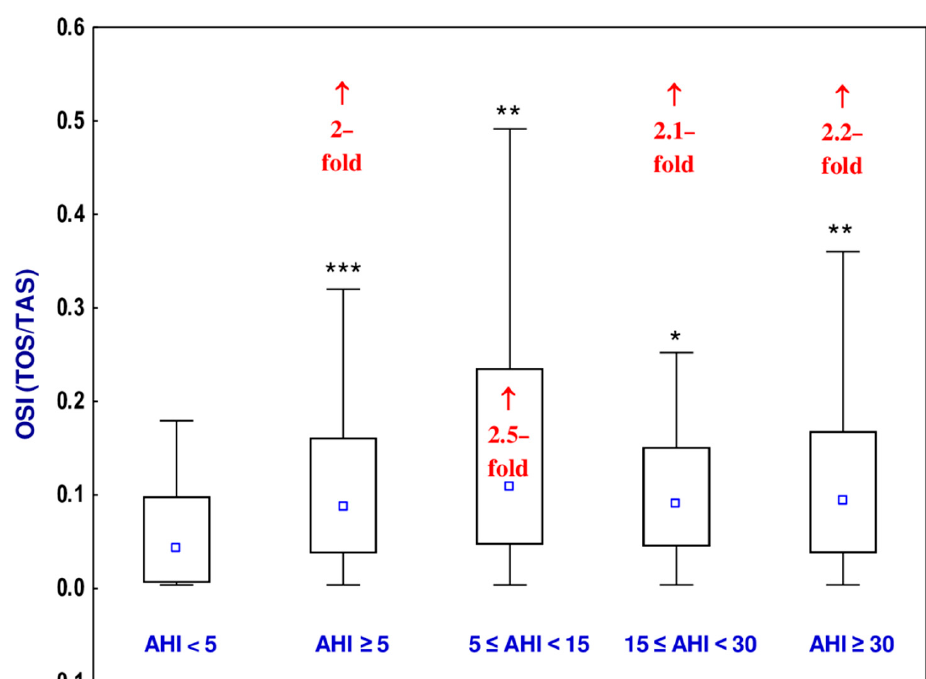
Figure 4. Oxidative stress index (OSI) in the uvular mucosa of the participants with obstructive sleep apnea syndrome (OSAS) and in non-OSAS participants. Data represent median, 25–75% confidence interval, as well as minimum and maximum. * p < 0.05, ** p < 0.01, *** p < 0.001 compared to apnea–hypopnea index (AHI) < 5. ↑ —increase compared to AHI < 5.